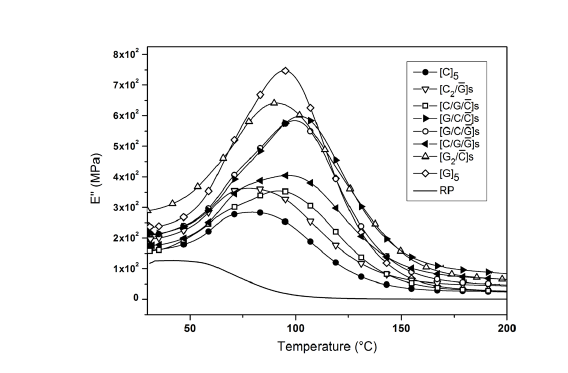
Figure 6. Storage modulus (E’) curves of the resin and the laminates. Figure 7. Loss modulus (E’’) curves of the resin and the laminates.